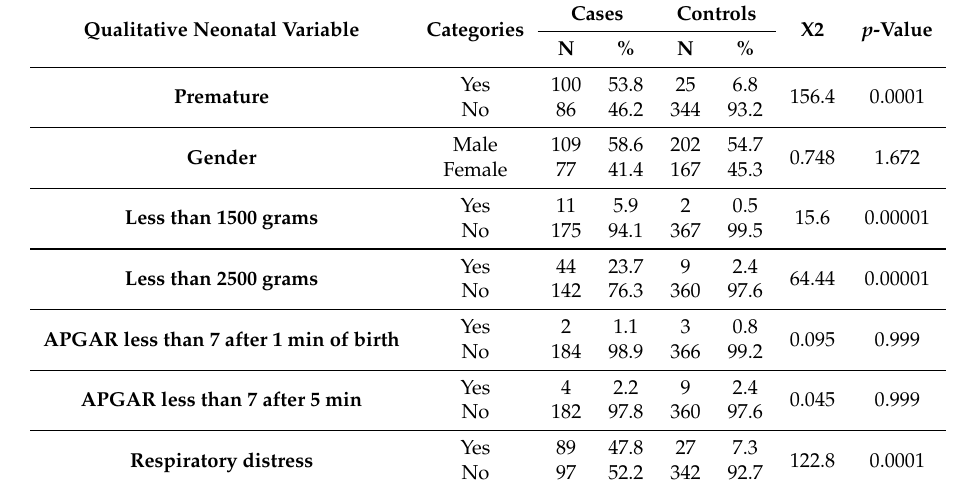
Table 7. Qualitative Neonatal variables in cases (186) and controls (369).